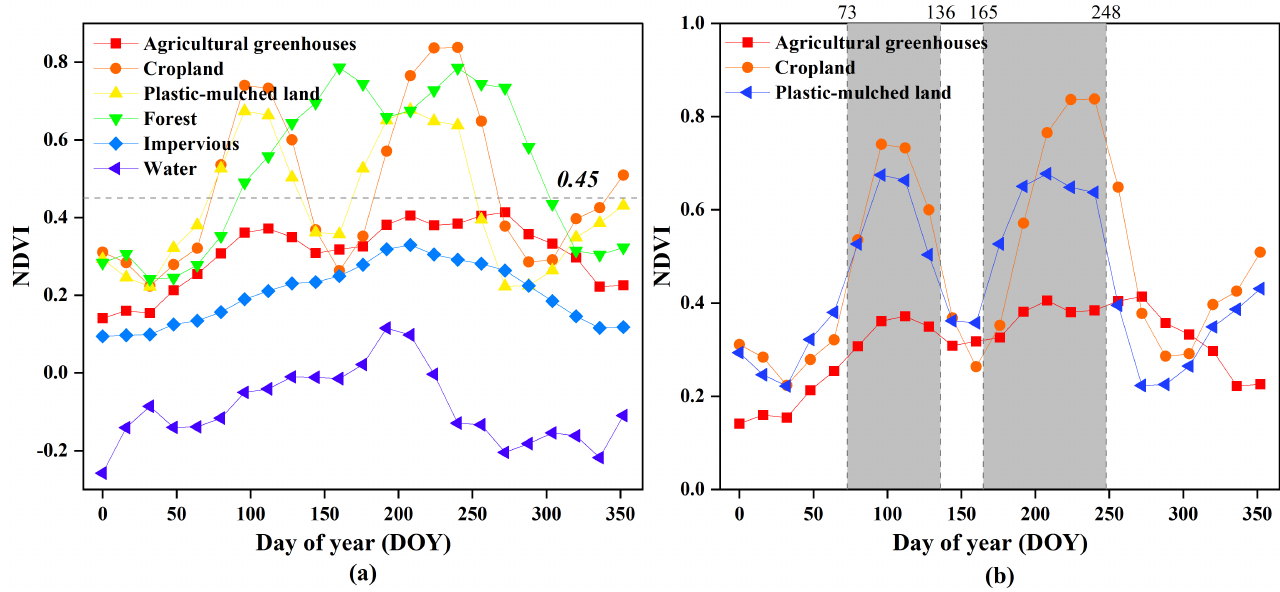
Figure 6. ( a , b ) Mapping window selection based on vegetation growth. Due to the complex crop structure in AG, we collected the phenological information of cropland and plastic-mulched land in Shandong province (Figure 7). Winter wheat (WW), summer corn (SUC) and spring corn (SPC) are the dominant crop type of cropland in Shandong province, DOY 73-136 are mainly in the reviving, jointing and heading stage of WW and the planting and seeding stage of SPC, and DOY 165-248 are mainly in the ripening and harvest stage of WW, and the seeding, jointing, tesseling and repending- harvest stage of SUC or SPC. Meanwhile, garlic (GA) and cotton (CO) are the dominant crop type of plastic-mulched land in Shandong province, DOY 73-136 are mainly in the differentiation stage of GA and the planting and seeding stage of CO, and DOY 165-248 are mainly in the repending-harvest stage of GA and the square-boll and picking stage of CO. Referring to the crop calendars for the dominant crops in Shandong province, both mapping windows are for the period that the vegetation growth is flourishing. However, as the major gain production crop in Shandong province, WW is usually harvested in late DOY 165-248, while all kinds of crops are usually grown in DOY 73-136, which shows a better differentiation AG from cropland and plastic-mulched land than DOY 165-248. Therefore, combining the smoothed NDVI times-series and the phenological information, we finally selected DOY 73-136 (from 15 March to 15 May) as the best mapping window within a year for annual AG